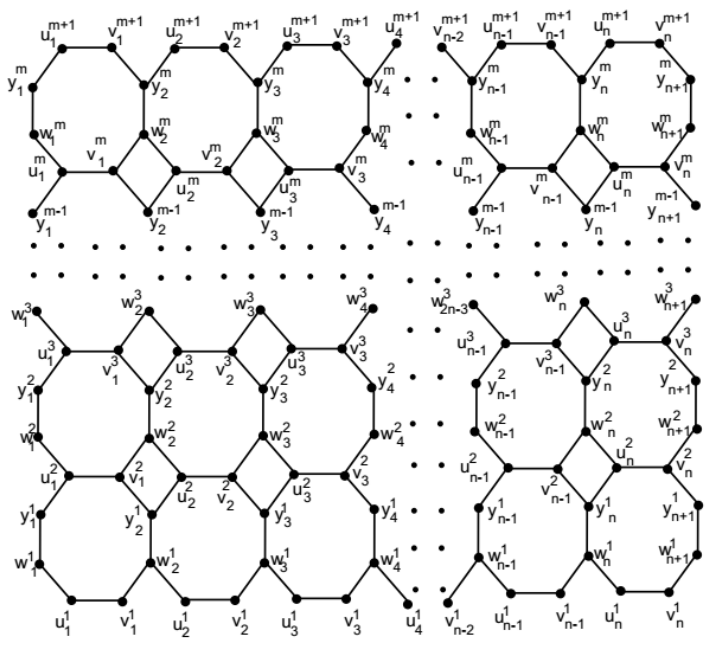
Fig. 1 The Octagonal grid O m